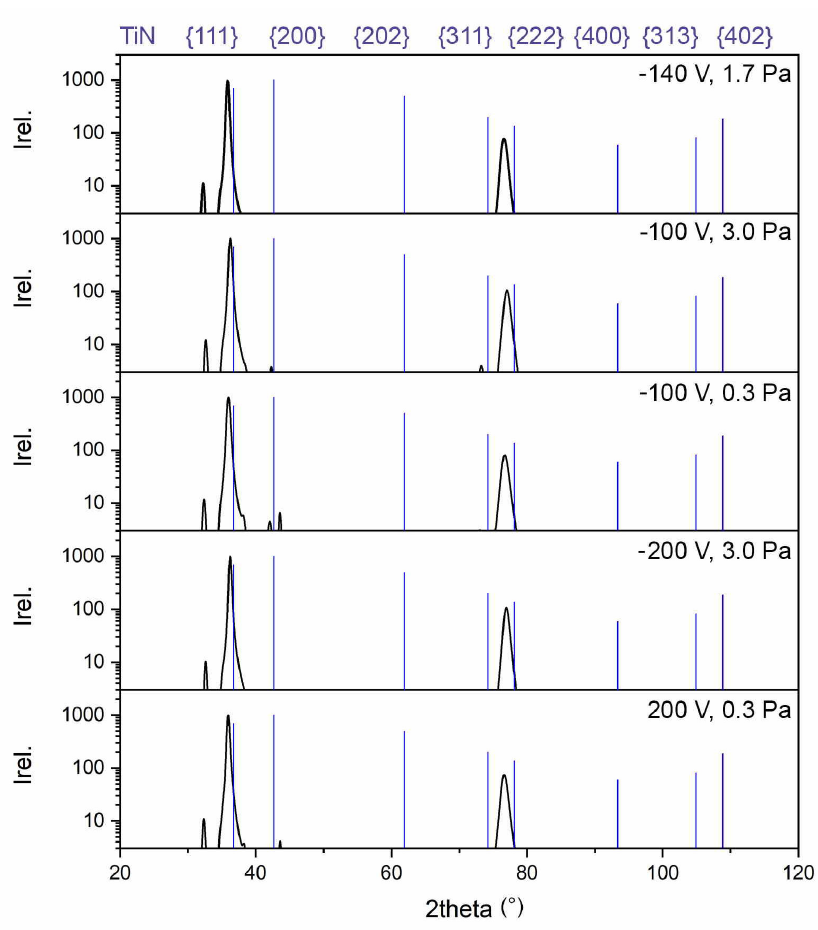
Figure 10. XRD Results.